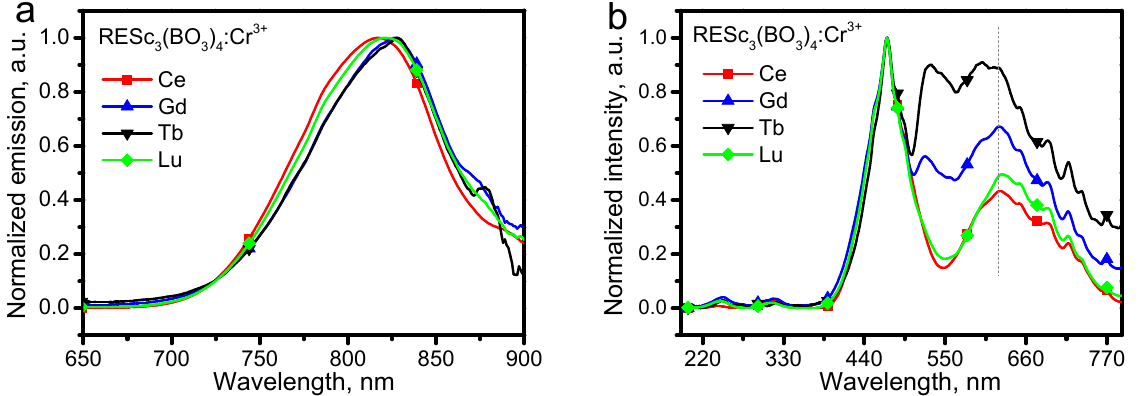
Figure 4. Normalized emission ( a ) and excitation ( b ) spectra of RESc 3 (BO 3 ) 4 :Cr 3+ ((RE = Ce, Gd, Tb, Lu), as corresponding to the emission and excitation spectra in Figure 1a and 1b, respectively.